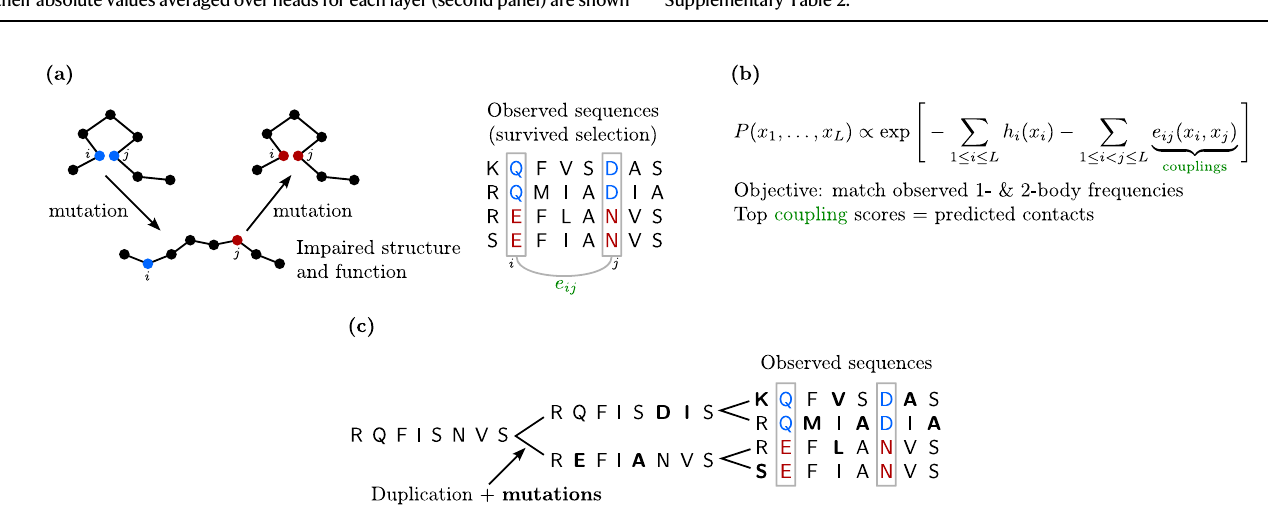
correlations in their pairwise couplings. c Historical contingency can lead to cor- relations even in the absence of structural or functional constraints.